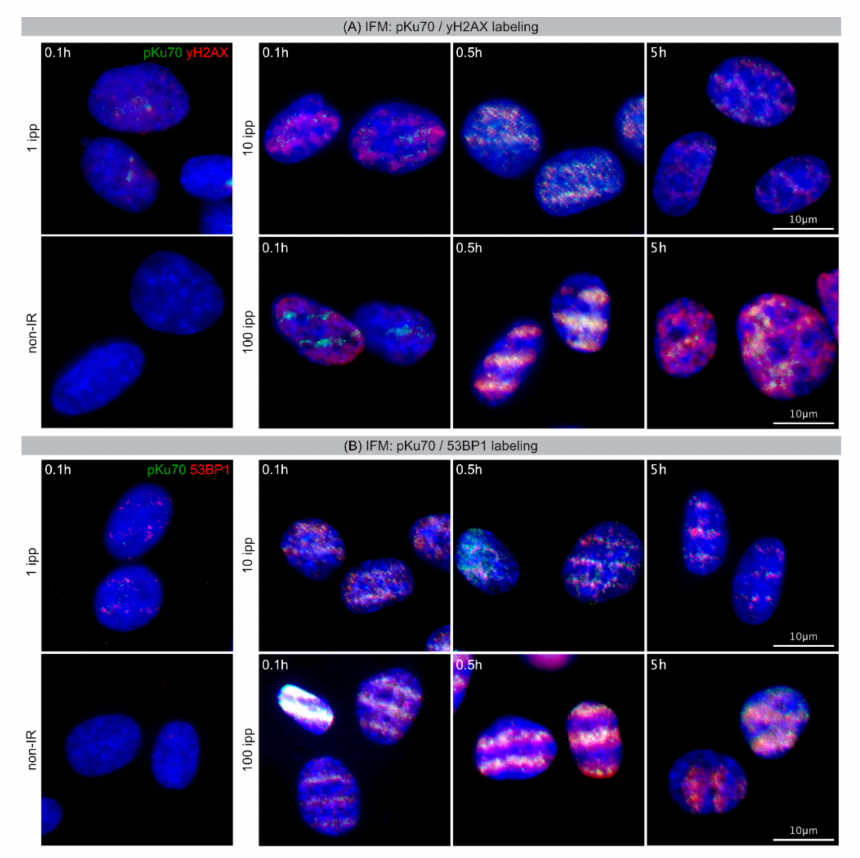
Figure 1. Radiation-induced DNA damage patterns visualized by conventional IFM. ( A ) Micrographs of double-staining for pKu70 (green) with γ H2AX (red) in DAPI-stained nuclei analyzed at 0.1 h, 0.5 h and 5 h after linear microbeam IR with 1, 10 and 100 ipp carbon ions, compared to non-irradiated cells. ( B ) Micrographs of double-staining for pKu70 (green) with 53BP1 (red) in DAPI-stained nuclei analyzed at 0.1 h, 0.5 h and 5 h after linear microbeam IR with 1, 10 and 100 ipp carbon ions, compared to non-irradiated